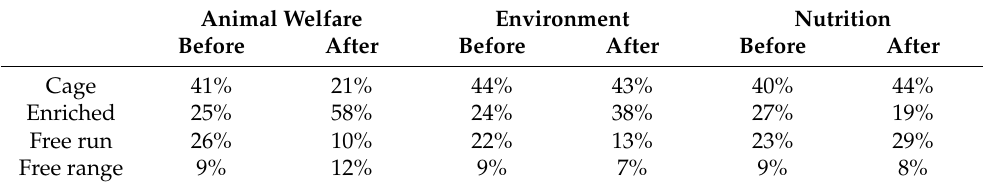
Table 6. Changes in the choice of type of eggs for a dozen eggs before and after the information treatment. Animal Welfare Environment